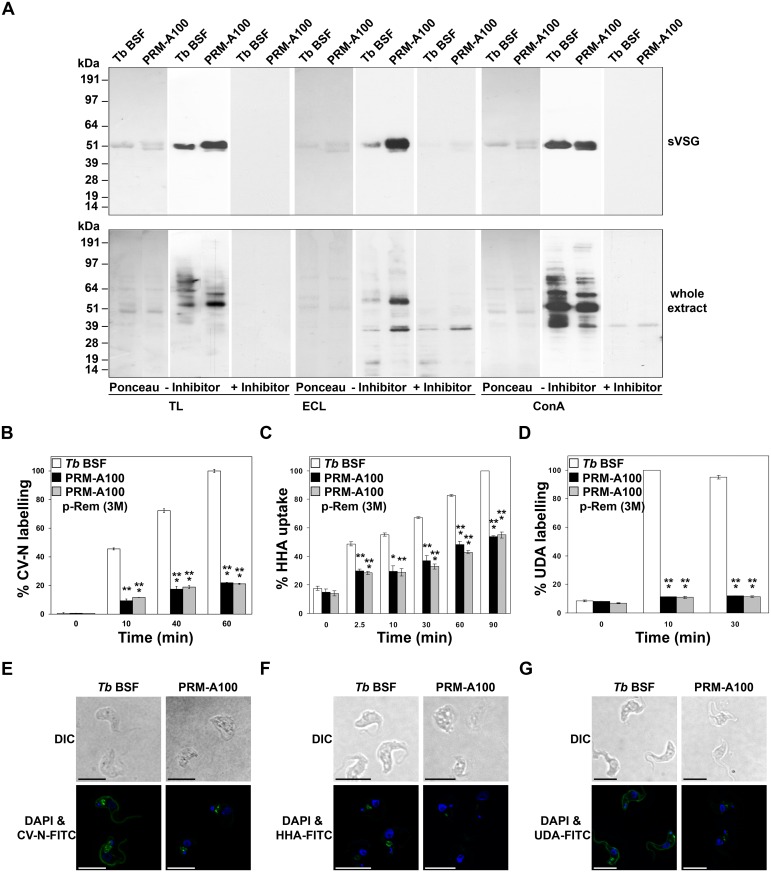
Assessment of the VSG glycosylation status by lectin blotting and labelling with lectins.(A) sVSG and cell pellets lysates obtained after hypotonic lysis from parental and PRM-A100 lines were subjected to SDS-PAGE, transferred to a nitrocellulose membrane and probed with TL, ECL and ConA lectins. Ponceau staining was used as loading control. Addition of chitin hydrolysate (inhibitor), D-lactose and α-methyl mannose was used as a specificity control for TL, ECL or ConA, respectively. (B-G) Live cells of parental and PRM-A100 lines were labelled with CV-N-FITC (B and E), HHA-FITC (C and F) or UDA-FITC (D and G) conjugates and fluorescence was quantified by FACS analysis and visualized by 3D microscopy. Bars, 10 μm. The asterisks show significant differences calculated by the Student’s t-test (n = 3). *, p < 0.05, **, p < 0.01 and ***, p < 0.005 vs the parental strain.